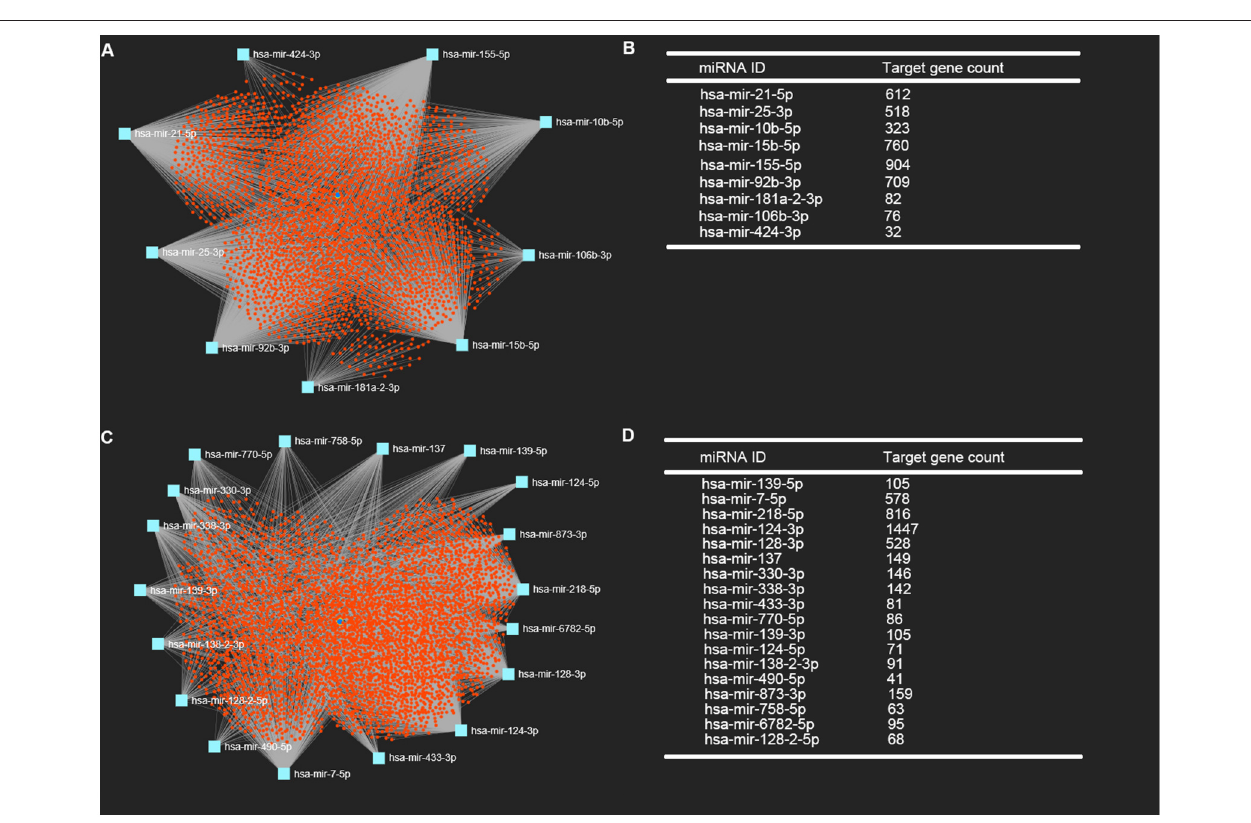
FIGURE 3 | Potential target genes of DE-miRNAs predicted by miRNet database. (A) Upregulated DE-miRNAs-target genes network constructed using miRNet; (B) downregulated DE-miRNAs-target genes network constructed using miRNet; (C) target gene count for each upregulated DE-miRNA; (D) target gene count for each downregulated